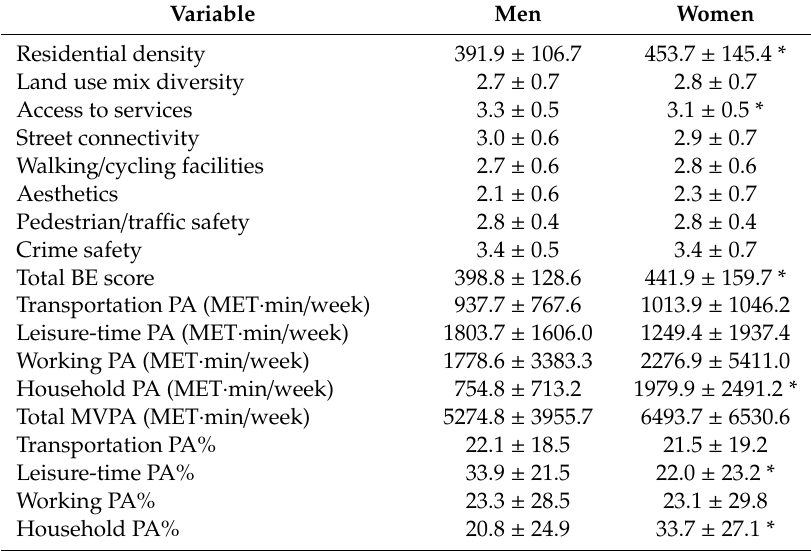
Table 2. Description of BE, PA, and physical fitness in di ff erent sex groups (mean ±